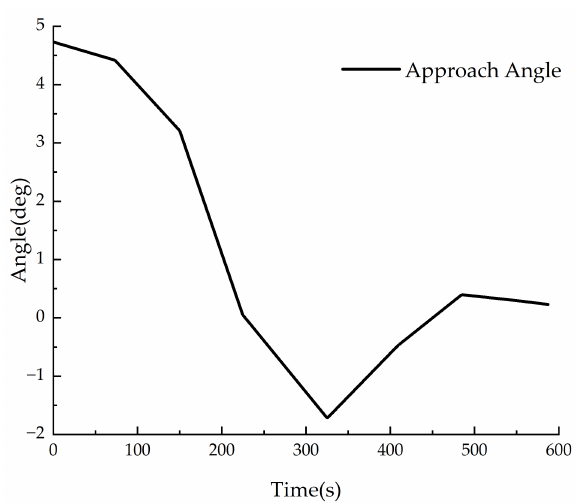
Figure 19. Approach angle relative to the dock.